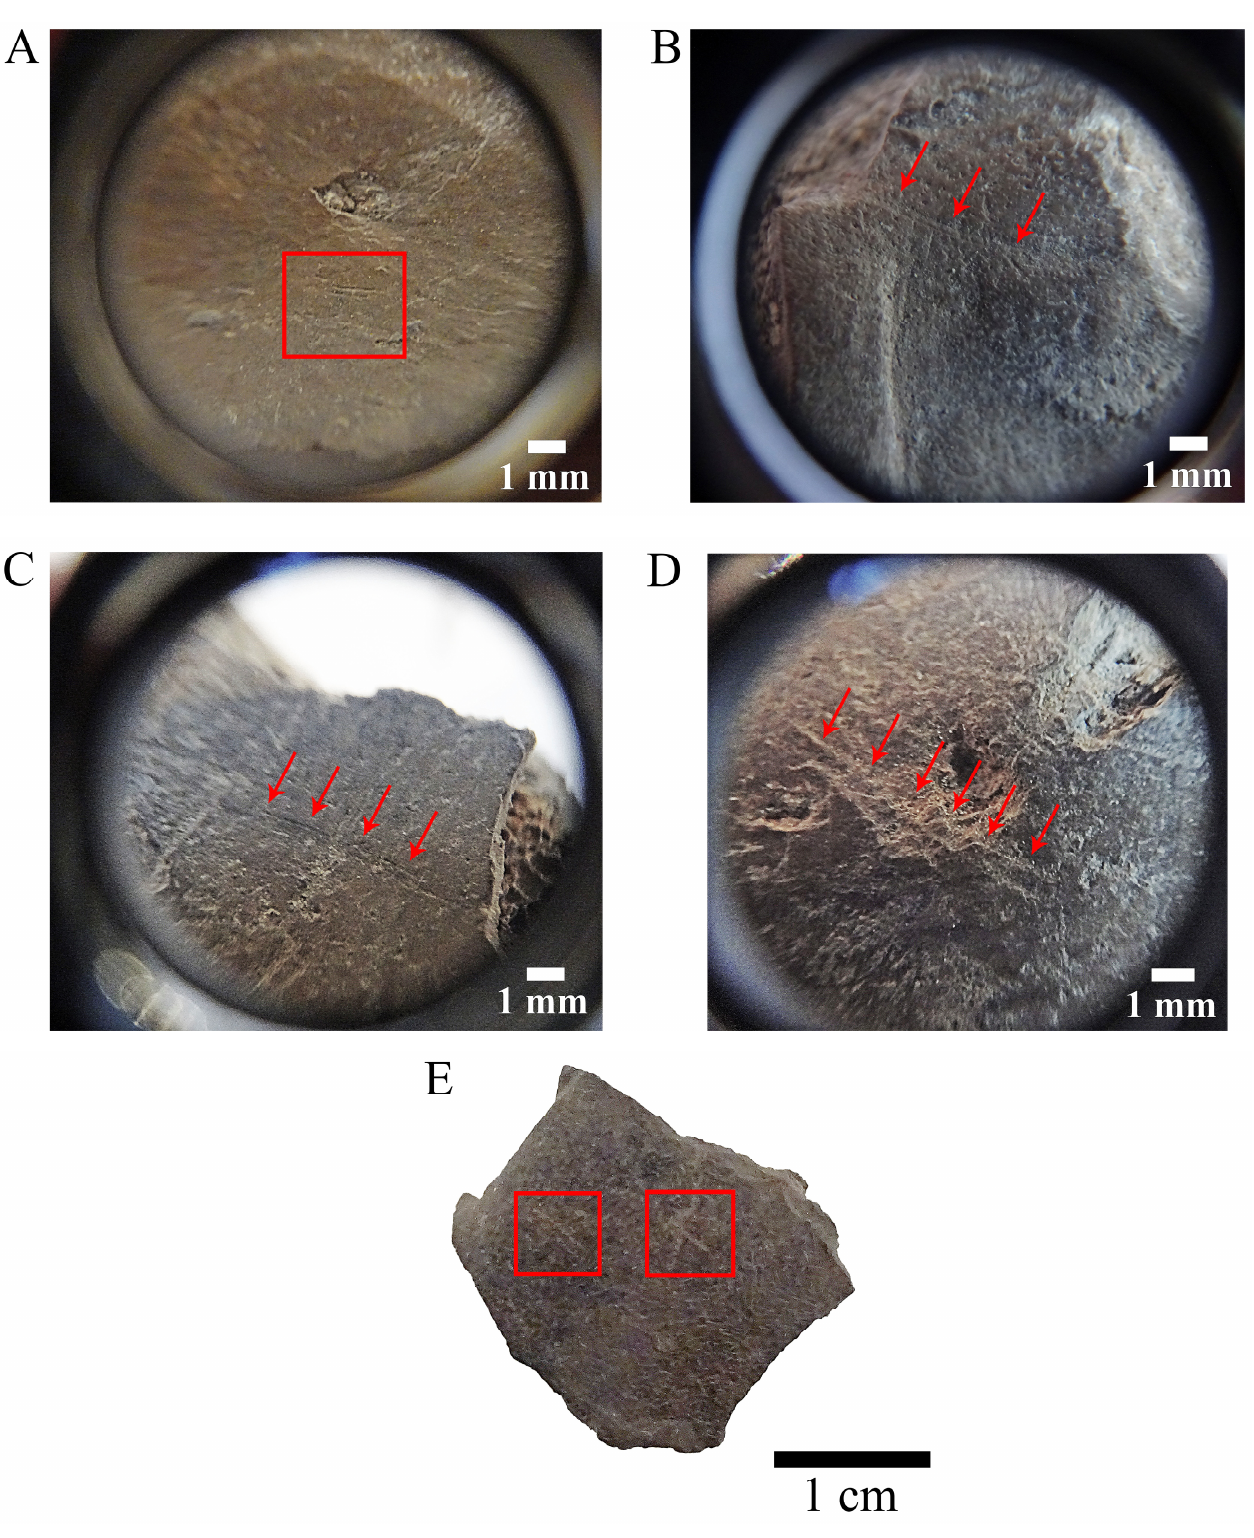
Figure 5. Details of incisions and scratches groups in turtle remains from the Middle Palaeolithic site of Mealhada (Coimbra, central Portugal). Arrows and boxes mark the identified alterations. For each specimen alteration type, see Table 2. Testudinidae indet. left peripheral 7 detail ( A ). Freshwater terrapin indet. peripheral indet. Detail ( B ). Mauremys leprosa left hyoplastron detail ( C , D ) and right hyoplastron ( E ).